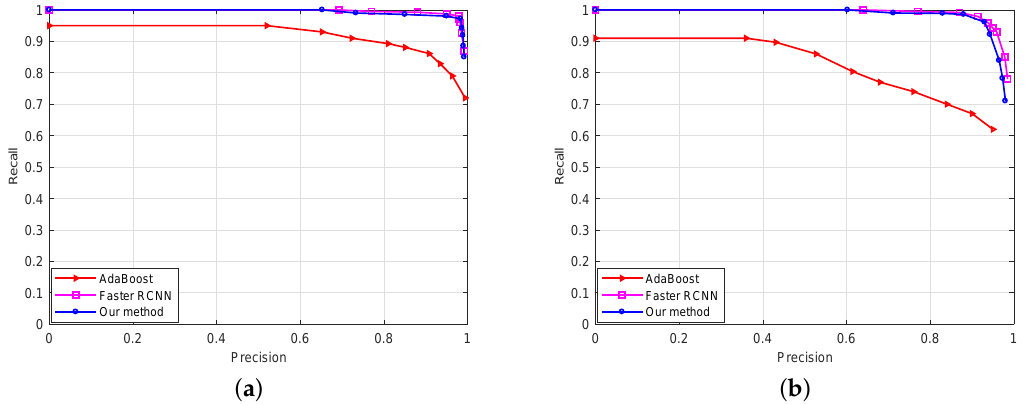
Figure 10. The ROC curves of AdaBoost, faster faster regions with CNN (CNN) and the proposed method: ( a ) shows the ROC curves of these three methods tested on circular signs; ( b ) shows the ROC curves of these three methods tested on triangular